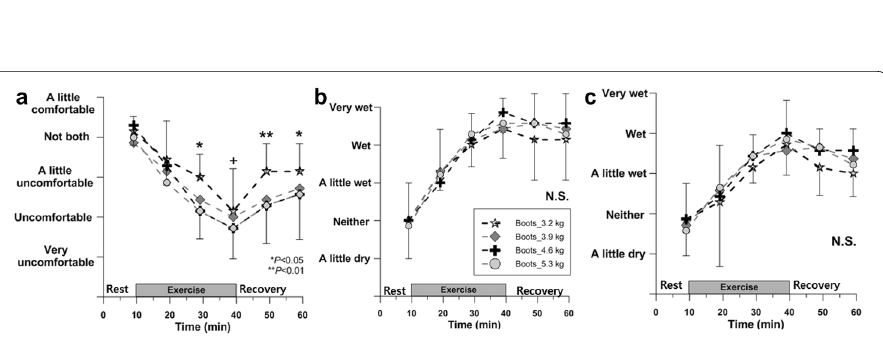
Fig. 5 Time courses of feet thermal comfort ( a ), overall sweat sensation ( b ) and feet sweat sensation ( c ). * P < 0.05, ** P < 0.01, and *** P <